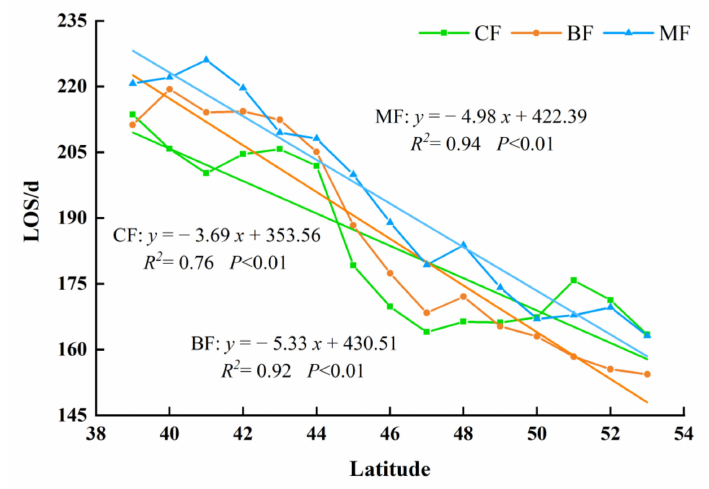
Figure 13. The variation trend of LOS in different forest types in Northeast China.